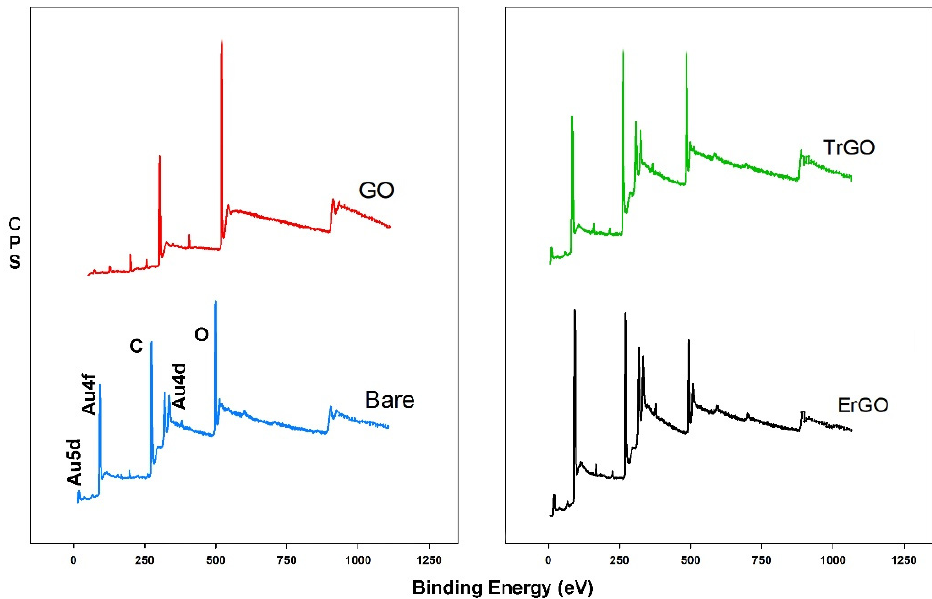
Figure 4. XPS spectra of the bare electrode and electrodes modified with GO, ErGO, and TrGO after the deposition of the AuNPs. The ErGO showed the highest At% for Au.